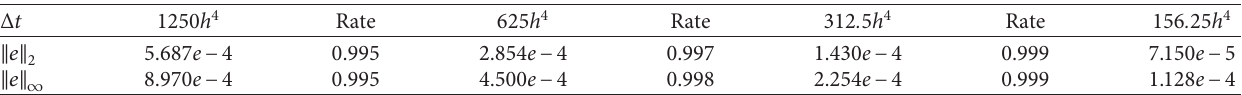
Figure 4: Errors between the reference solution and the solutions evaluated using (a) the LSS and (b) the CN scheme at t � 10 7 h 4 . Table 3: Errors and convergence rates for the numerical results of the LSS at the final time T � 10 7 h 4 . Here, h � 1/128 is used.